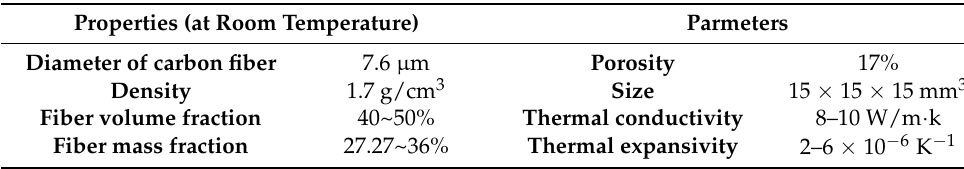
Table 1. Material characteristics of the 2.5D C f /SiC [34].